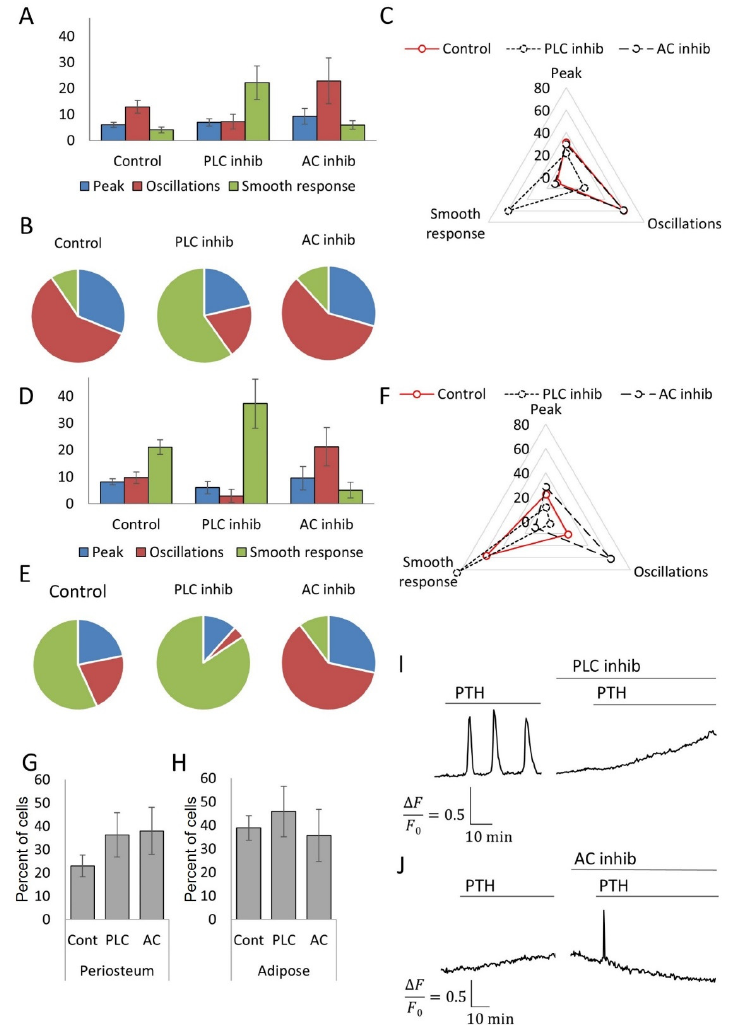
Figure 5. Inhibitory analysis of adipose-derived and periosteum-derived MSCs. ( A – C ) Influence of inhibition of PLC and AC on adipose-derived MSC responding to PTH. The number ( A ) and share ( B ) of adipose-derived MSC responding in the different ways of calcium response. ( C ) Radar chart of changes in the share of adipose-derived MSC responding in the different ways of calcium response. ( D – F ) Influence of inhibition of PLC and AC on periosteum-derived MSC responding to PTH. The number ( D ) and share ( E ) of periosteum-derived MSC responding in the different ways of